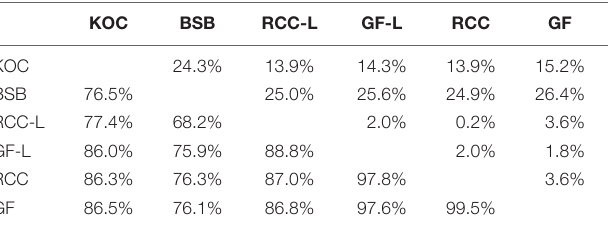
TABLE 2 | Nucleotide sequence similarity (below the diagonal) and divergence (above the diagonal) of the mtDNA control regions of KOC, BSB, RCC-L, GF-L, RCC, and